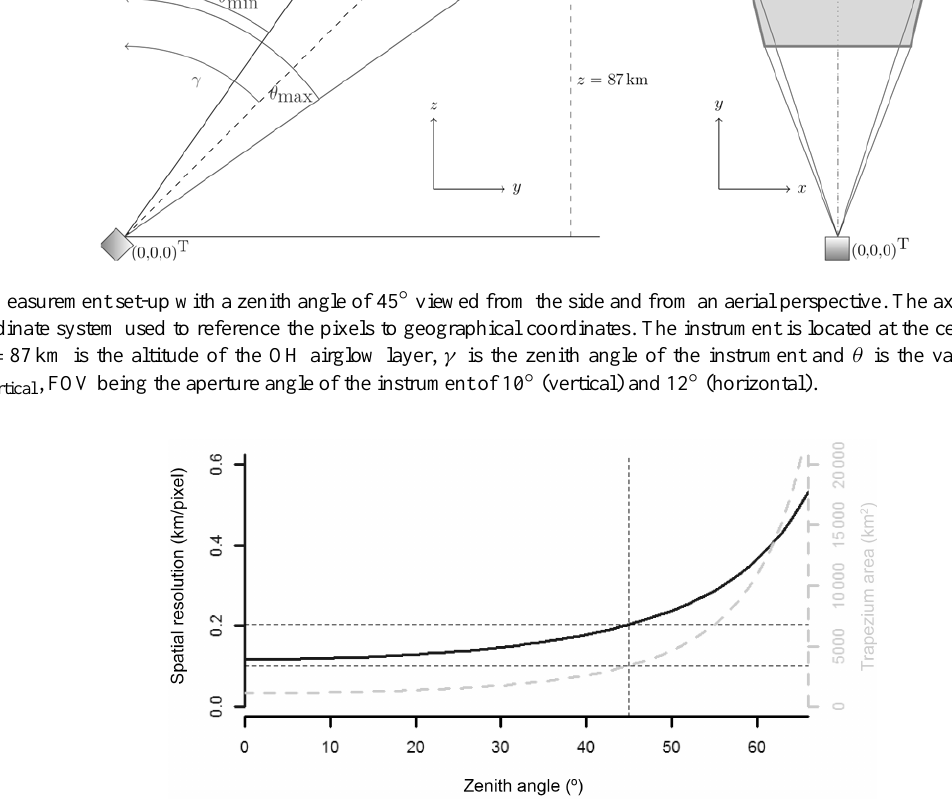
Figure 3. Mean spatial resolution of the acquired images as a function of zenith angle (black). The grey dashed line shows the respective area of the trapezium-shaped FOV with the axis on the right side of the graph. The standard angle of 45 ◦ is marked by thin dashed lines for both curves, showing a mean spatial resolution of 200m and a corresponding area of 3400km 2